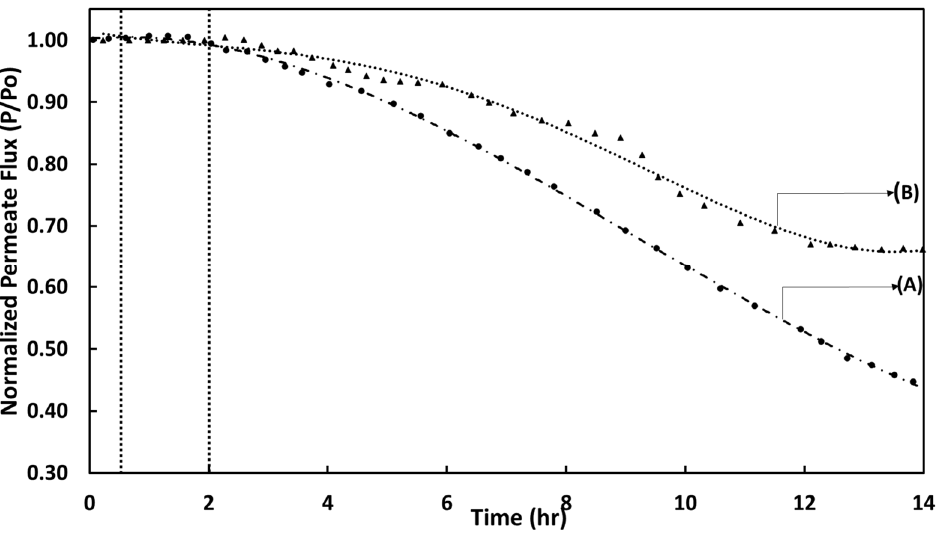
Figure 4. Normalized RO permeate flux during filtration tests for feed water treatment with configurations A (without UF) and B (with UF pretreatment). Crossflow velocity = 4.5 cm/s, Y plant = 63%, initial permeate flux = 33 L/m 2 h, and SI g,m = 1.9–2.0. P and P O are permeate flux values at time t and initially. Dotted vertical lines 1 and 2 denote early detection of particles/small crystals formed for RO operation with feedwater pretreated via configurations A and B, respectively (Figure 2).